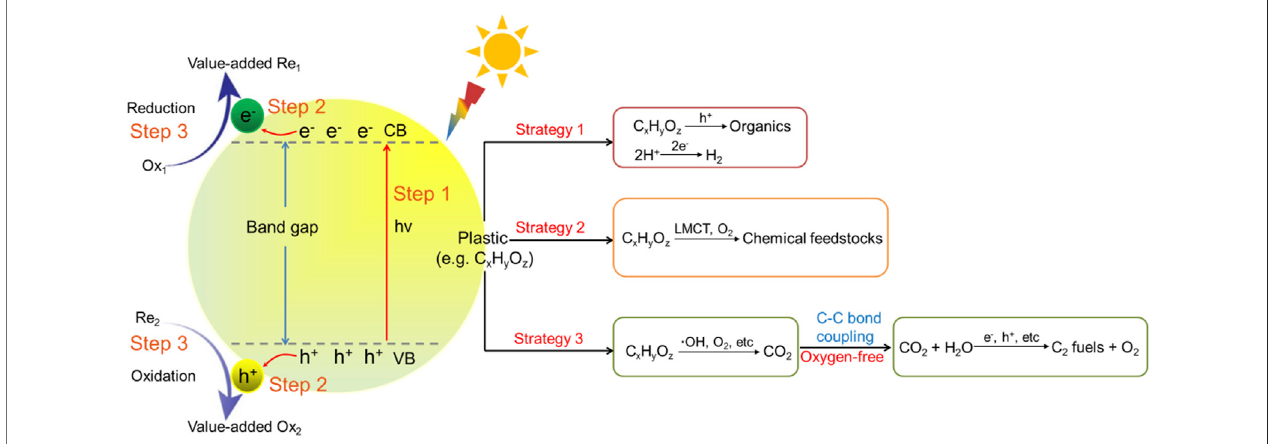
FIGURE 2 | Basic principle and three typical conversion pathways for photocatalytic valorization of plastic waste (LMCT refers to ligand to metal charge transfer).